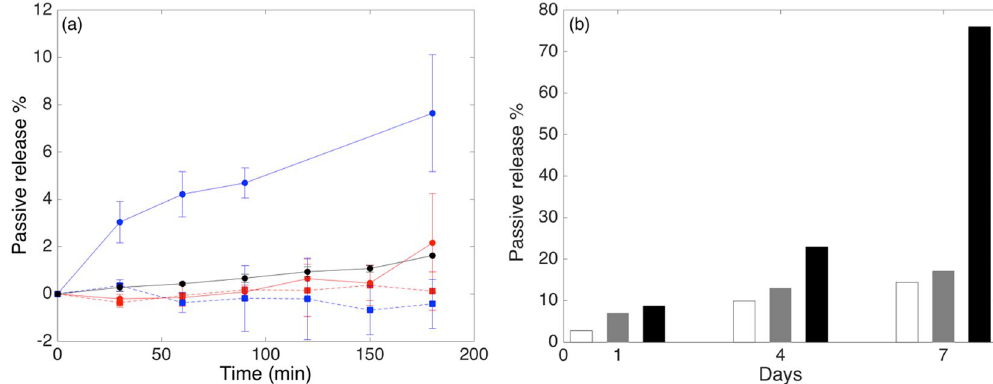
Figure 6. ( a ) Passive release for PEGylated magnetoliposomes containing 2 wt% (dotted) and 4 wt% (solid) SPION for liposomes comprising MPPC (blue), DPPC (red) or DSPC (black) lipid. The averages and standard errors of the mean are shown for measurements on two independent samples. ( b ) The passive release over one week for PEGylated DPPC liposomes: (white) kept at high vacuum for 72 h during lipid drying for chloroform removal, (gray) with 4 wt% SPION and chloroform removal using high vacuum for 72 h, (black) with 4 wt% SPION without chloroform removal using high